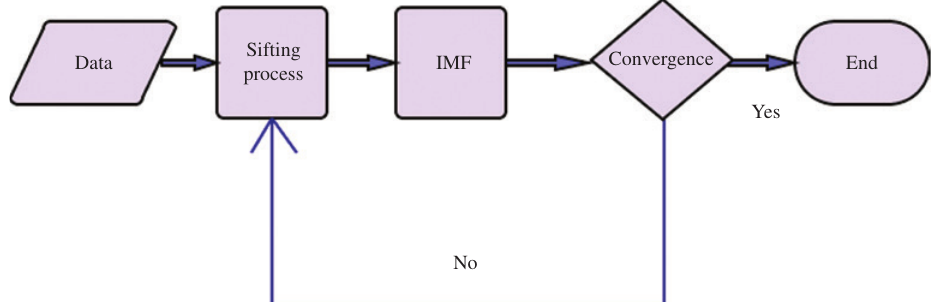
Figure 1: Flow Chart of